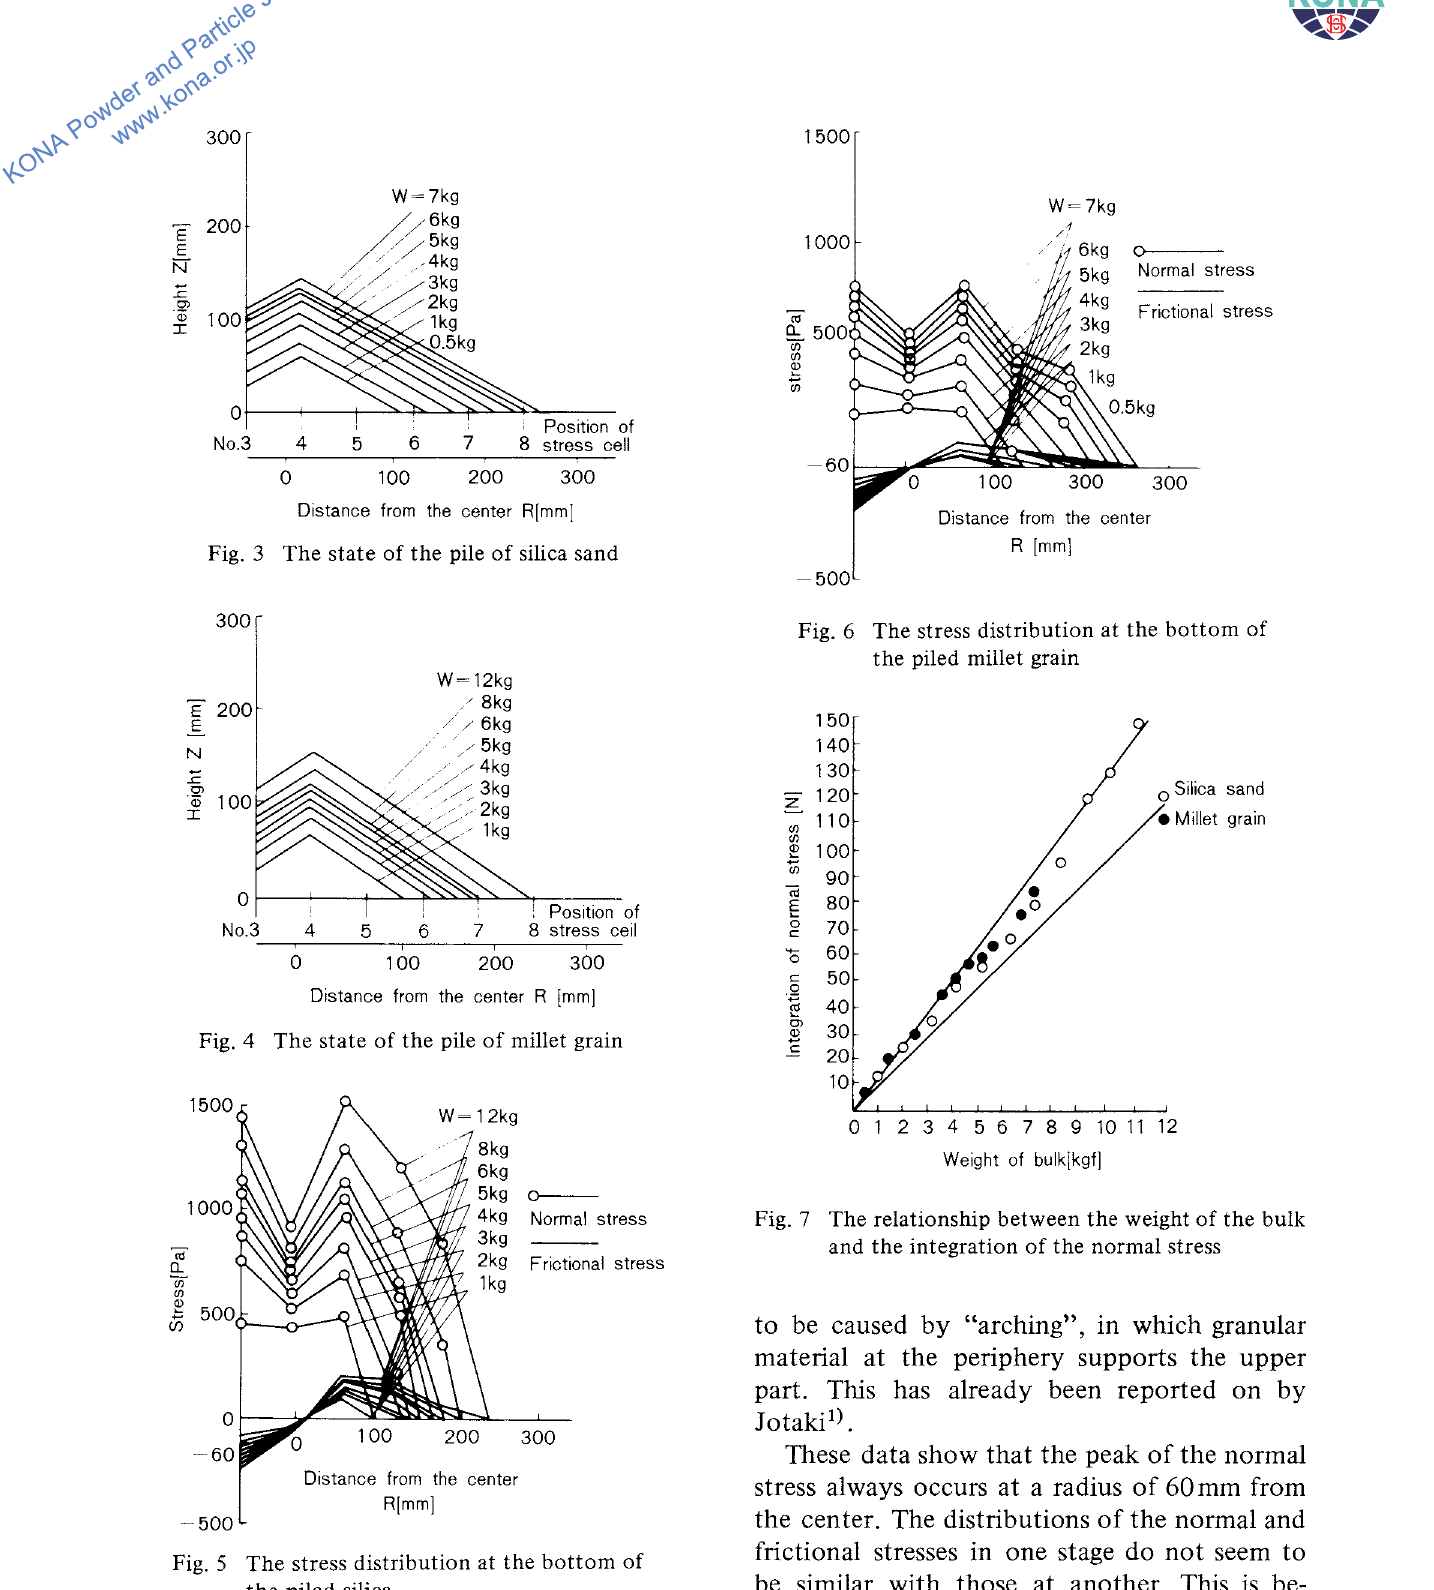
Fig. 5 The stress distribution at the bottom of the piled silica